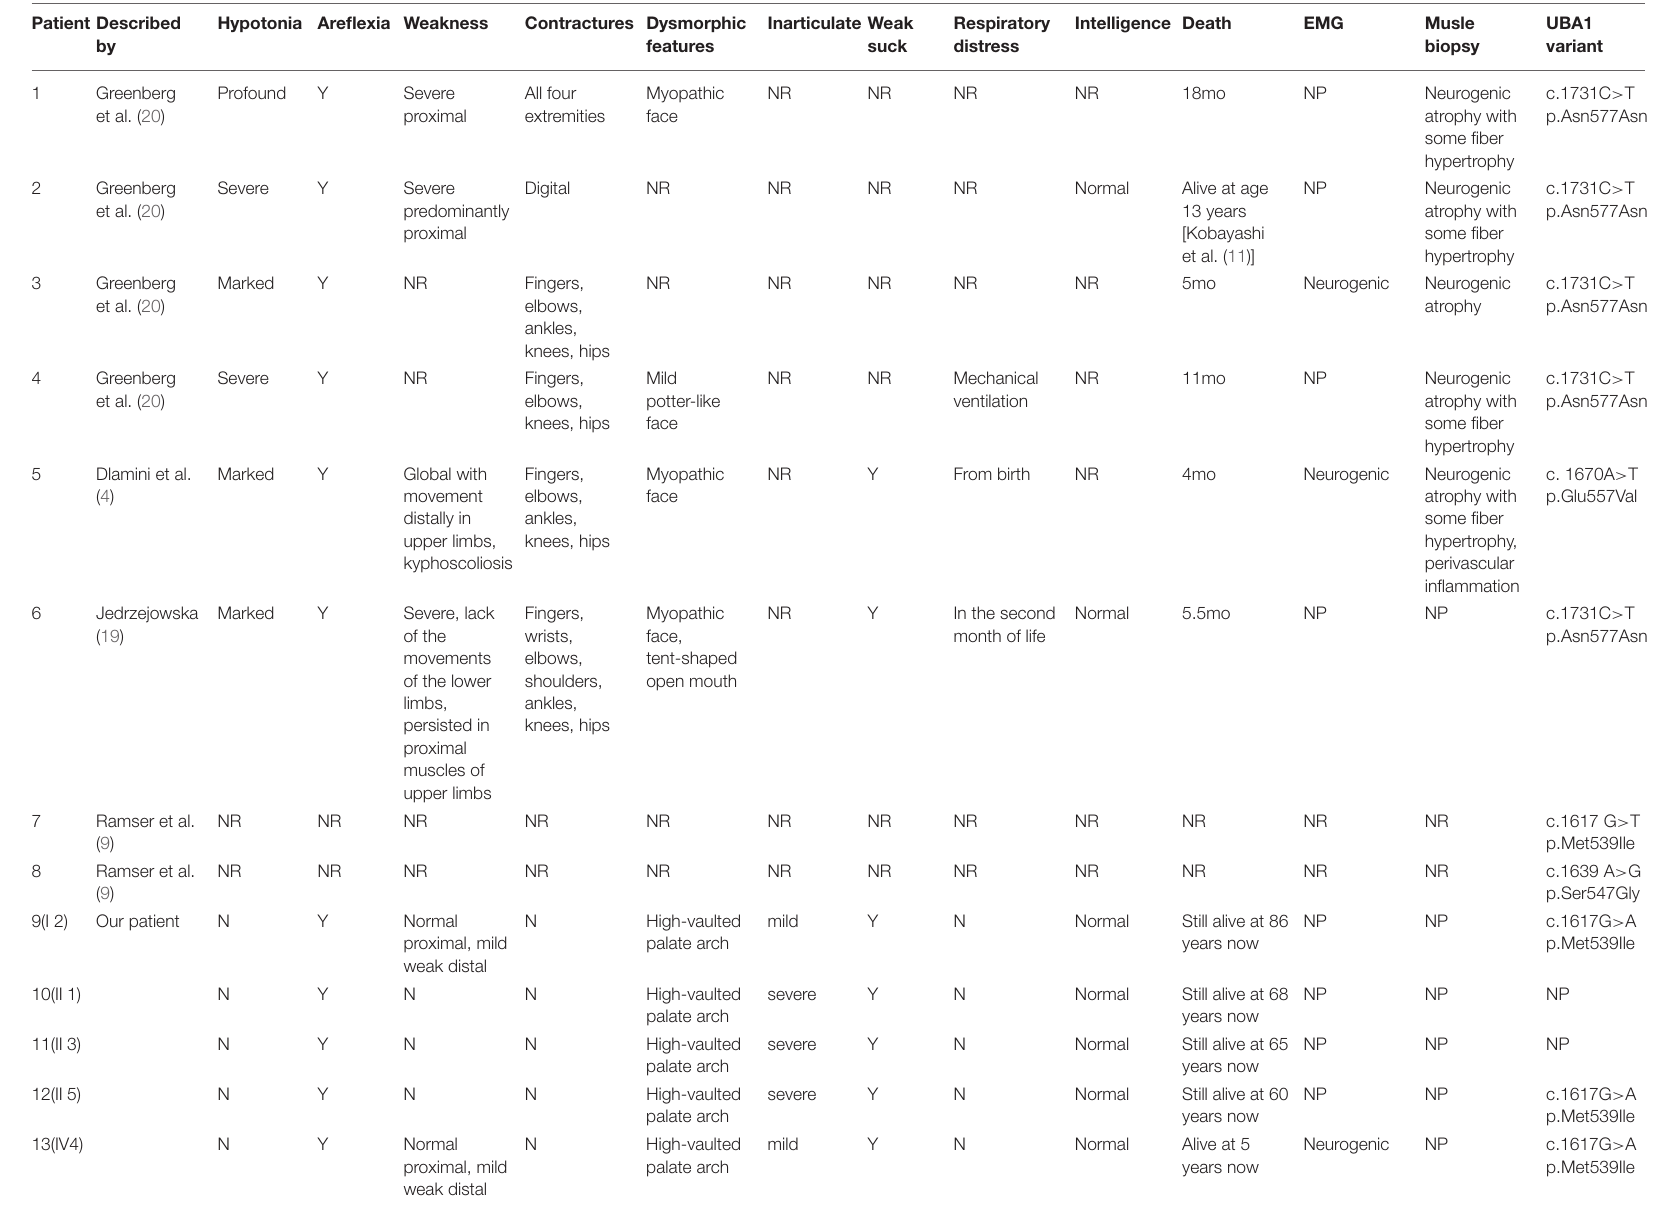
TABLE 1 | Clinical symptoms and gene variant sites of SMAX2 patients reported in literature. Patient Described